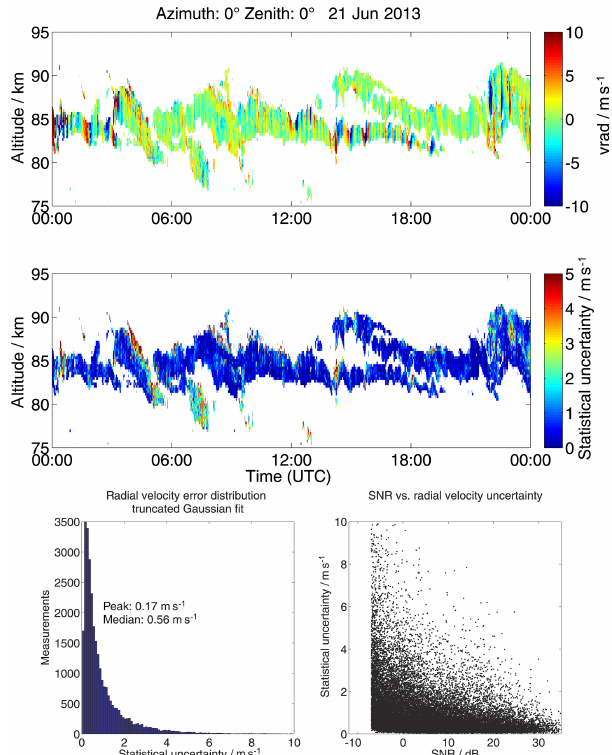
Figure 2. Stack plot of the radial velocity measurements with MAARSY. The lower panels show the color-coded statistical un- certainties of the radial velocity